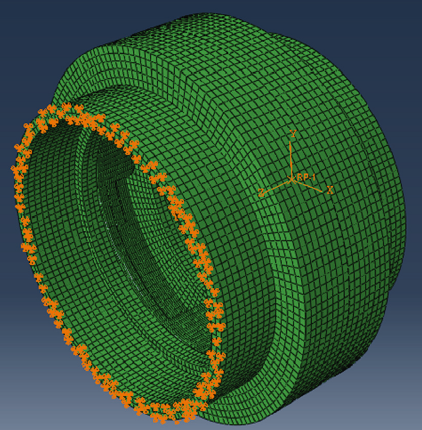
Figure 9: Boundary condition definition of the